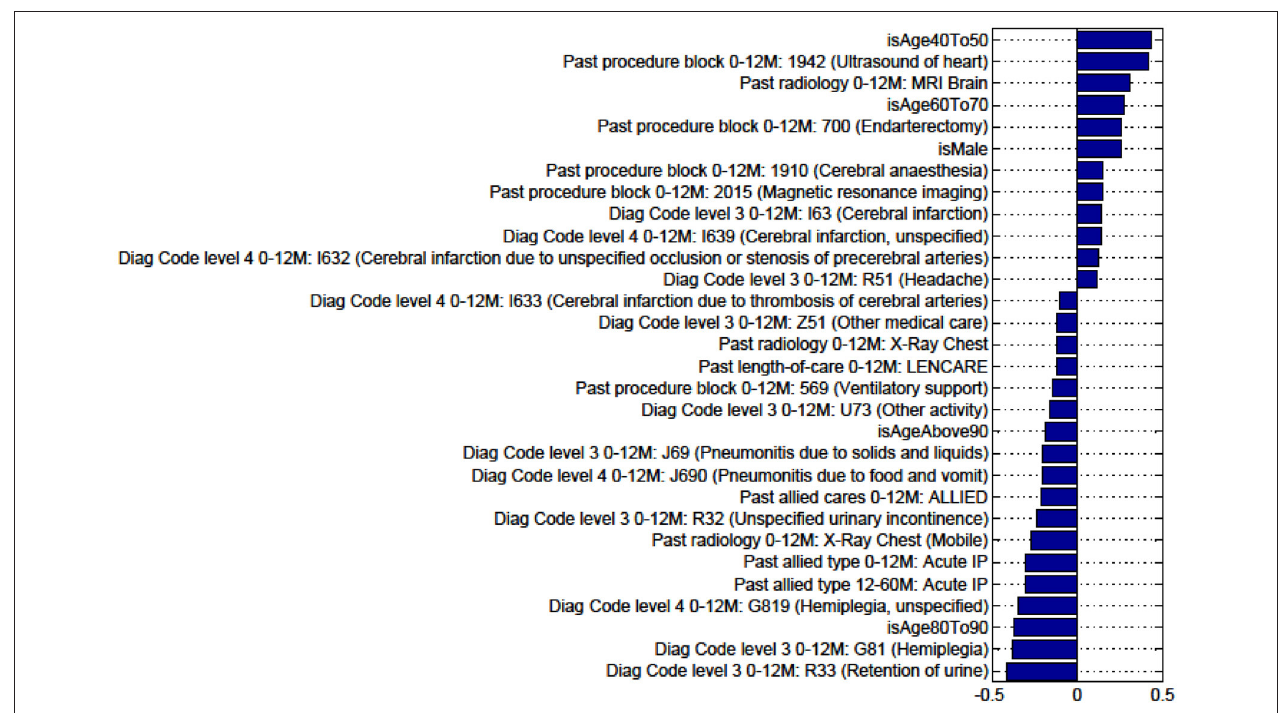
FIGURE A5 | Factors for prediction of Discharge Home vs all Other discharge destinations for the sub-cohort of ischaemic stroke patients.